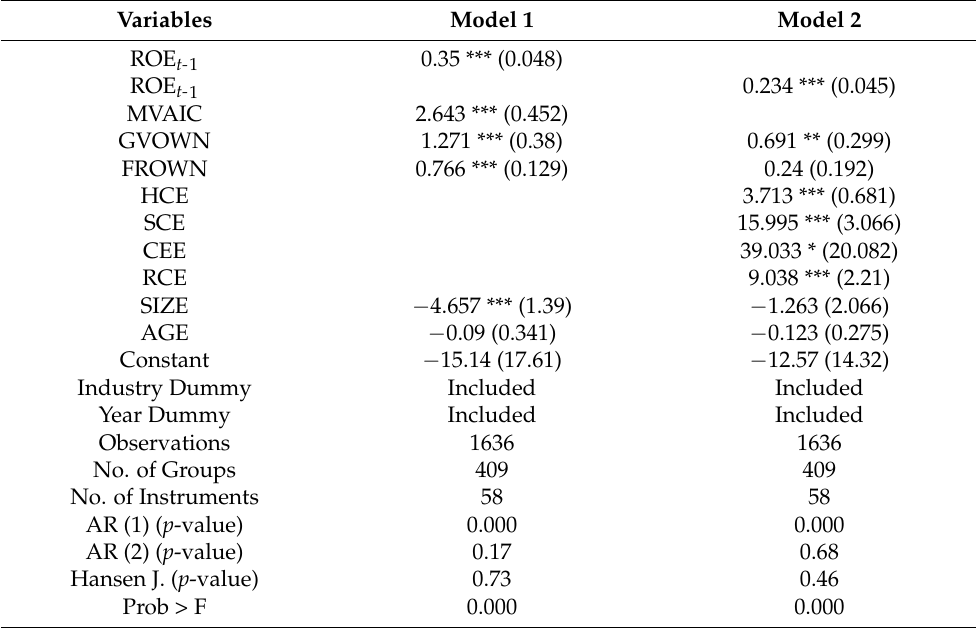
Table 6. Results of GMM regression (robustness test with